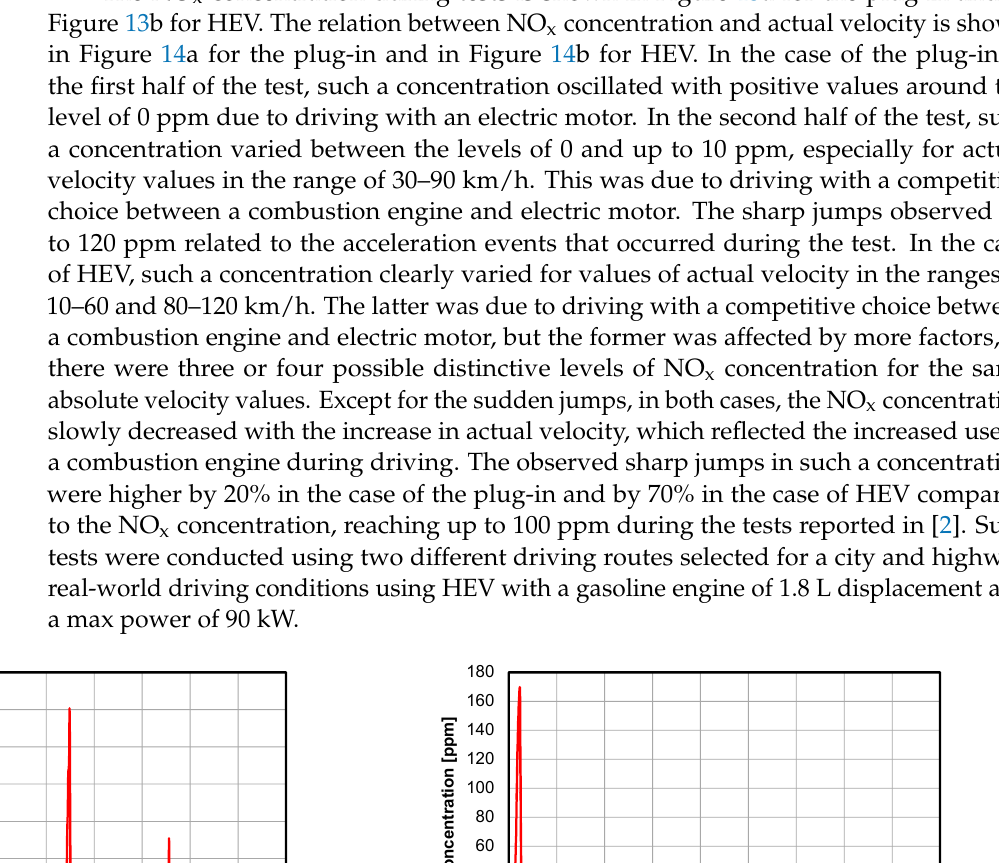
The NO x concentration during tests is shown in Figure 13a for the plug-in and in